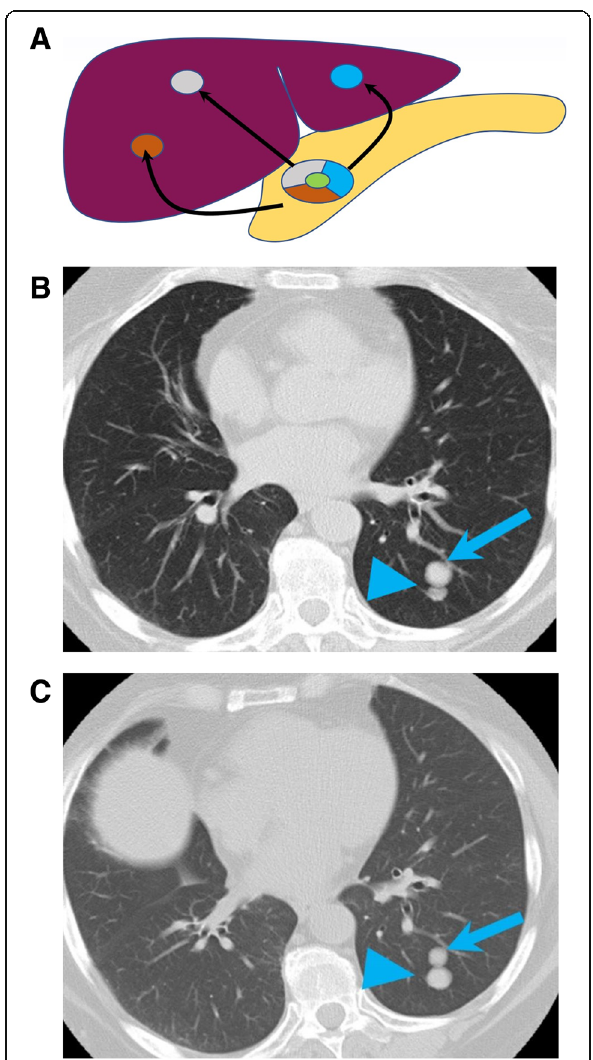
Fig. 8 Intermetastatic heterogeneity. a Image showing the heterogeneity within different liver metastases, each one arising from a different subclone in a primary pancreatic tumor. b Baseline and ( c ) follow-up axial CT images of the chest of a 77-year-old woman with leiomyosarcoma on pazopanib shows increase in size of a nodule (blue arrowhead), and interval decrease in size of an adjacent nodule (blue arrow), representing different response to the vascular endothelial growth factor inhibitor